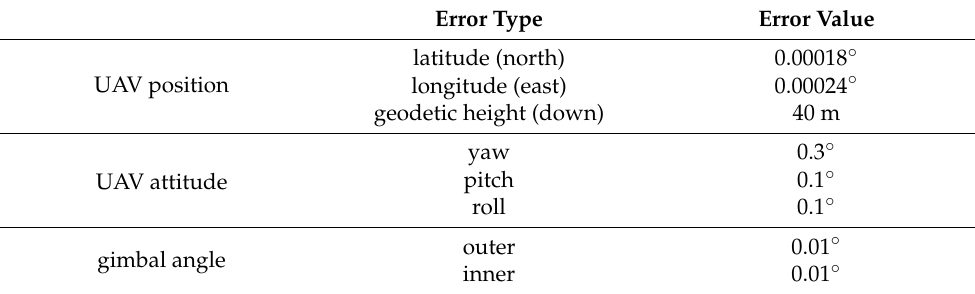
Table 1. Measurement Variances in Geo-location.